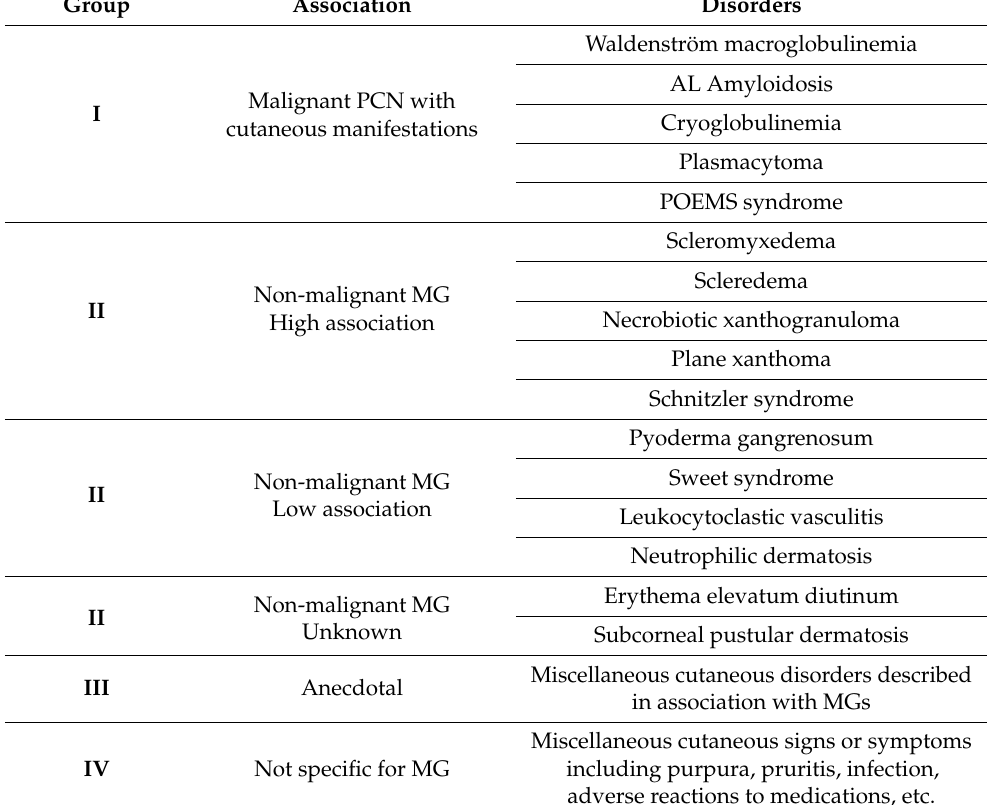
Table 5. Classification of MGSS-associated diseases. Group Association